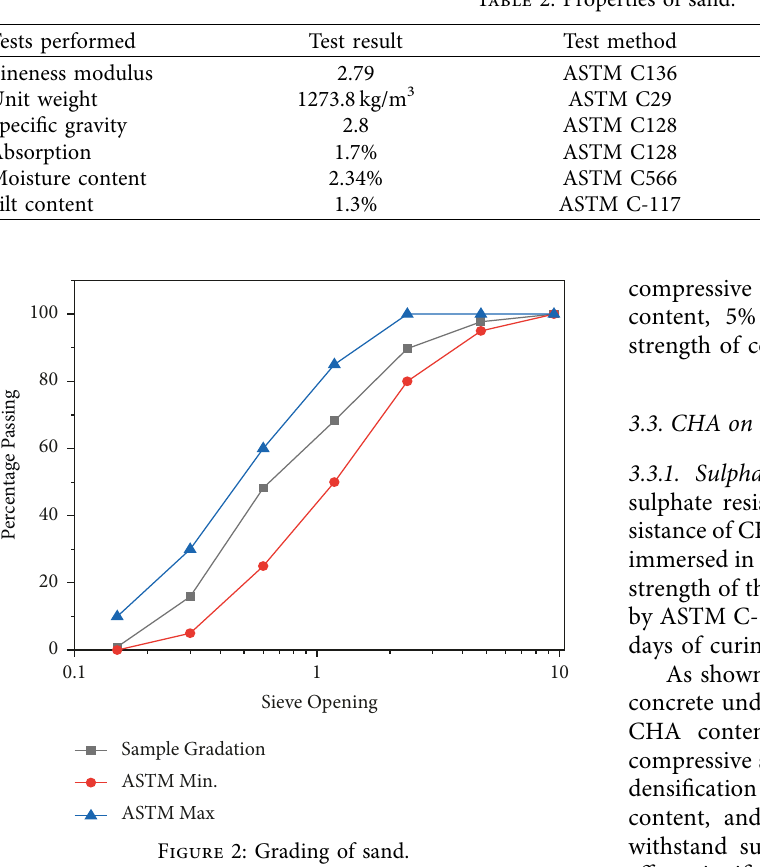
Figure 2: Grading of sand.